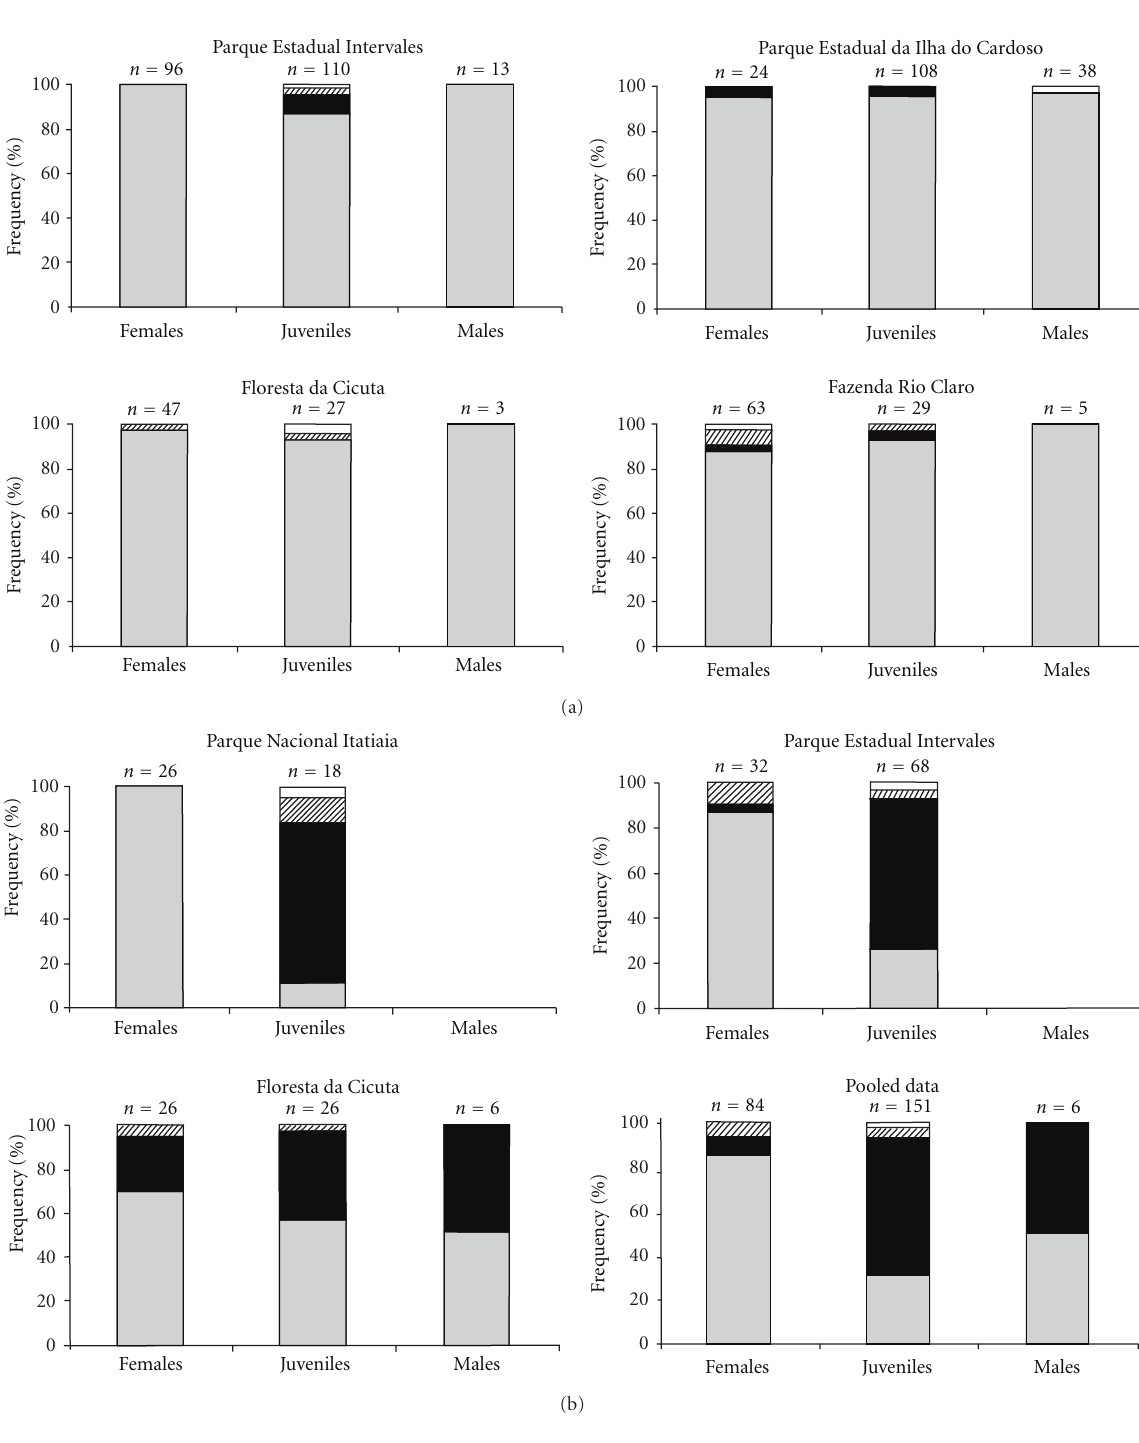
Figure 2: Frequencies of web decorations constructed by (a) C. fililineata and (b) Cyclosa morretes in the study areas. Grey bars: linear structures with detritus; black bars: linear discontinuous structures with detritus (blobs); bars with diagonal lines: complex types with detritus; white bars: linear silk + spiral silk